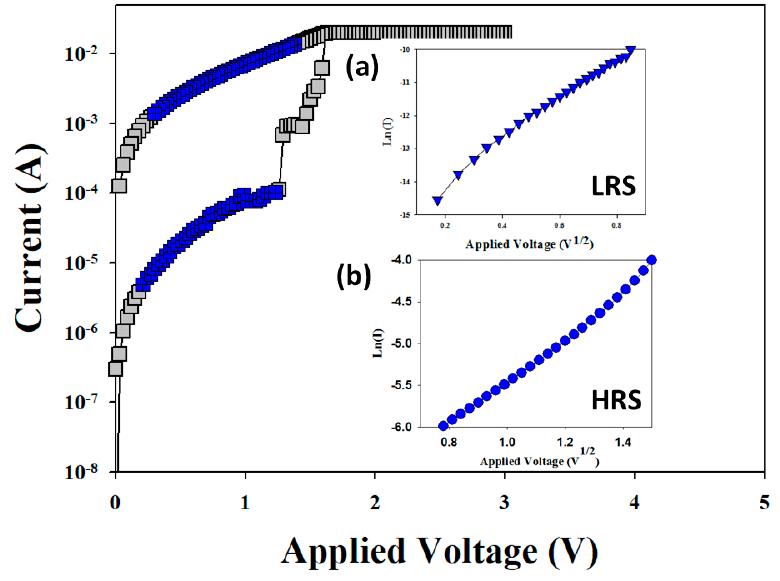
Figure 4. The ln( I )- V 1/2 curve of vanadium oxide thin film RRAM devices for ( a ) LRS, and ( b ) HRS.